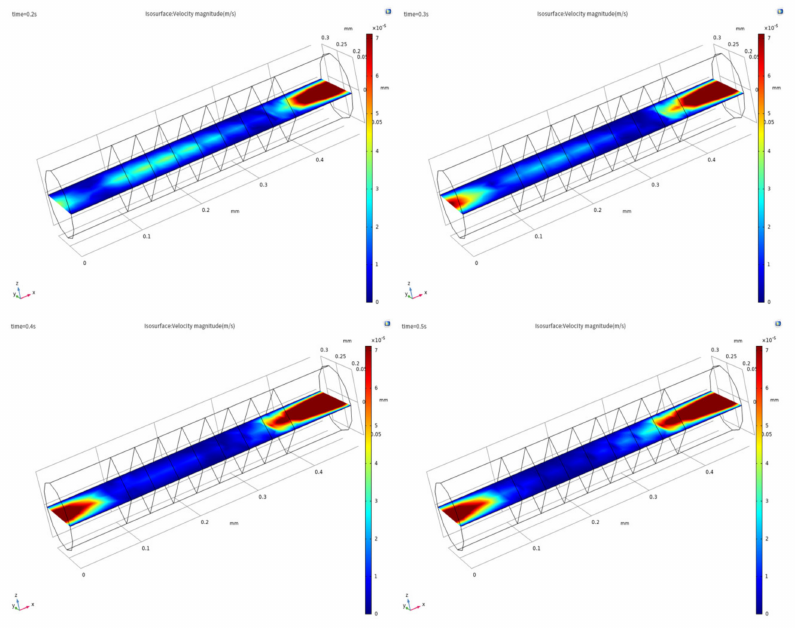
Figure 7. Axial velocity field distribution of the xy plane in the sensing element under sinusoidal excitation signal in the quarter